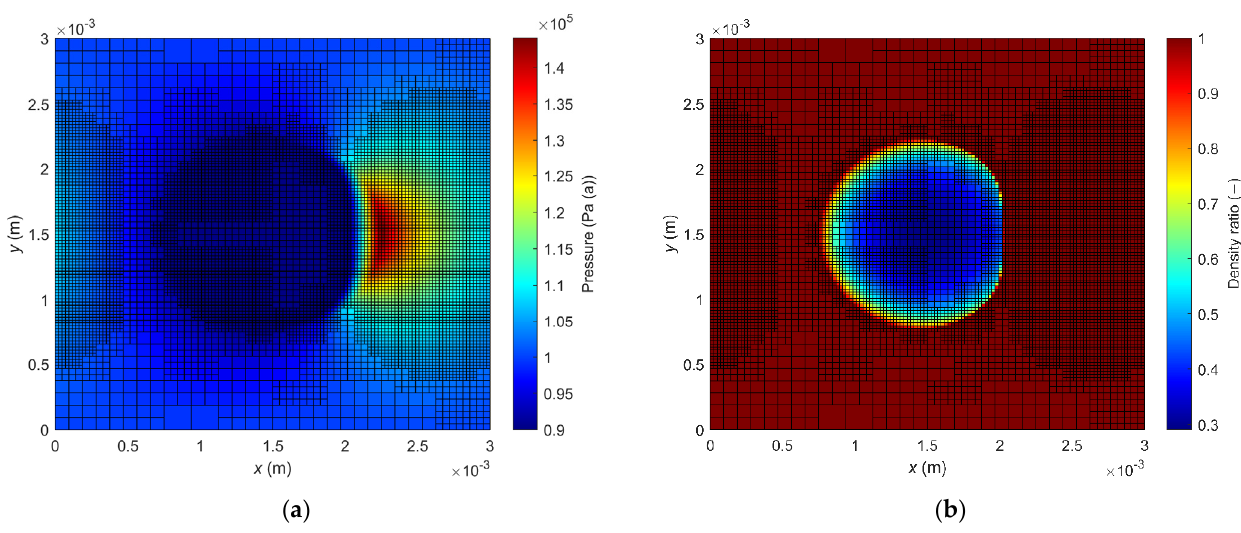
Figure 11. Final refined mesh for thrust bearing: ( a ) pressure distribution; ( b ) density ratio distribution.